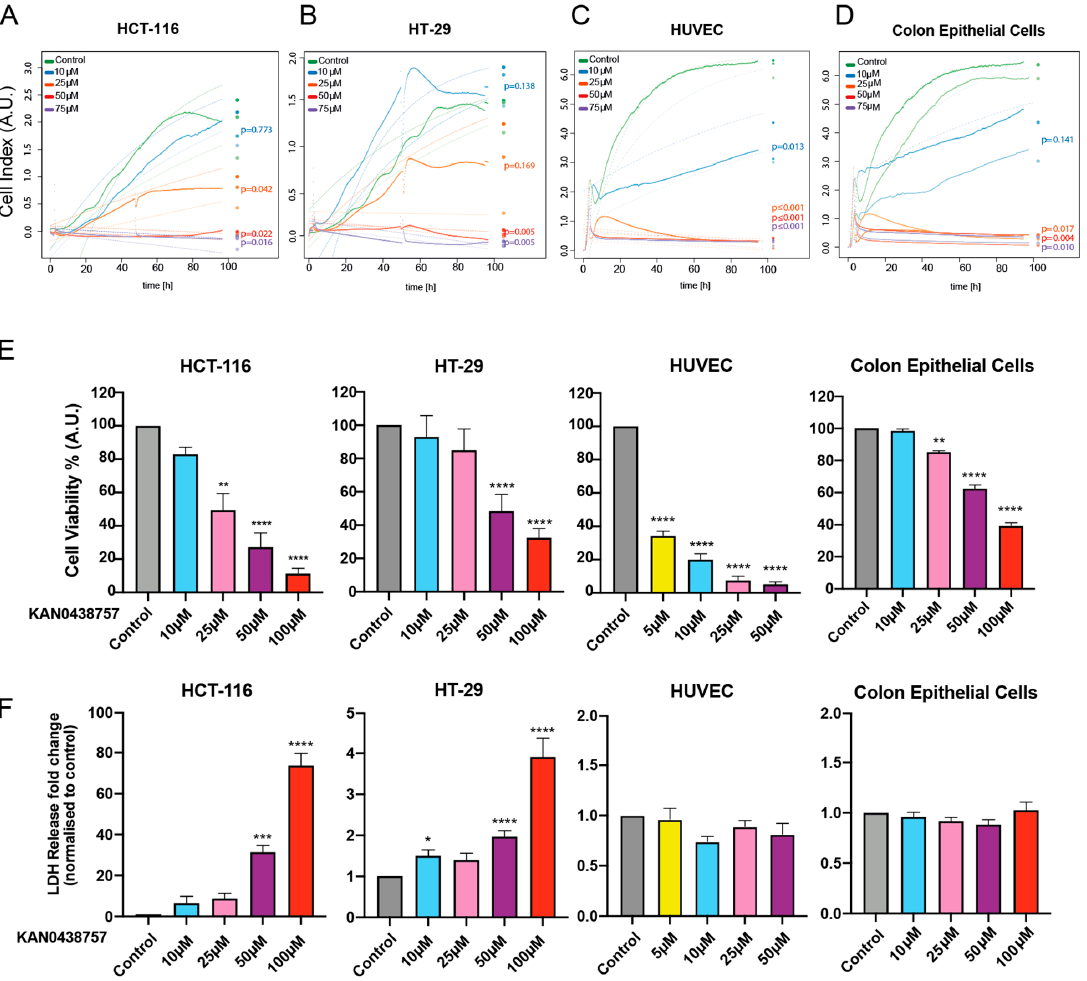
Figure 4. PFKFB3 inhibition by KAN0438757 reduces cancer cell proliferation and induces cell death in a concentration ‐ dependent manner. ( A , B , C , D ) xCELLigence assay performed with HCT ‐ 116 and HT ‐ 29 colorectal cancer cells, HUVECs and normal colon epithelial cells during 96 h under different concentrations of KAN0438757 (continuous line); the dotted lines represent the fitted saturation curve in logarithm. ( E ) CellTiterBlue assay performed with HCT ‐ 116, HT ‐ 29, HUVECs and normal colon epithelial cells during 48 h. ( F ) LDH assay performed with HCT ‐ 116, HT ‐ 29, HUVECs and normal colon epithelial during 48 h. Data is (cid:3399) SEM. (A–F) Combined data from three independent experiments. * p < 0.05; ** p < 0.01; *** p < 0.001; **** p <